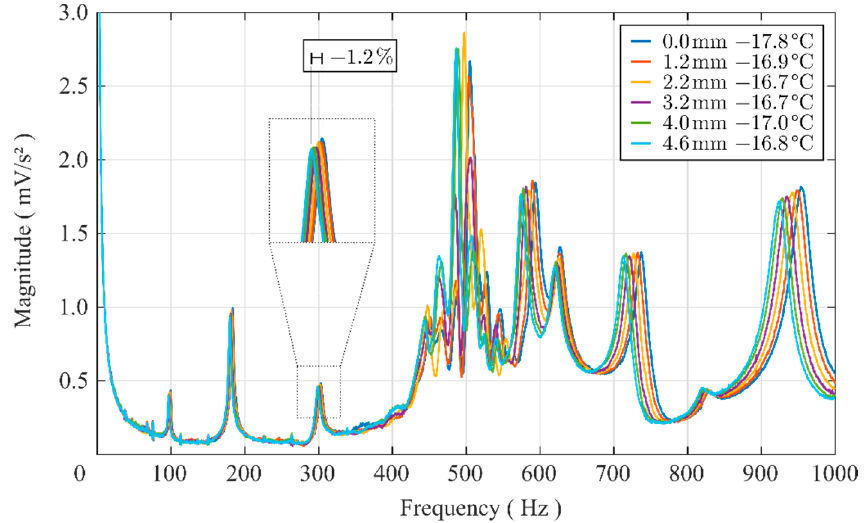
Figure 8. Frequency spectra illustrating the change in natural frequencies due to ice accumulation along the rotor radius, generated by opening all three nozzles (1, 1, 1).